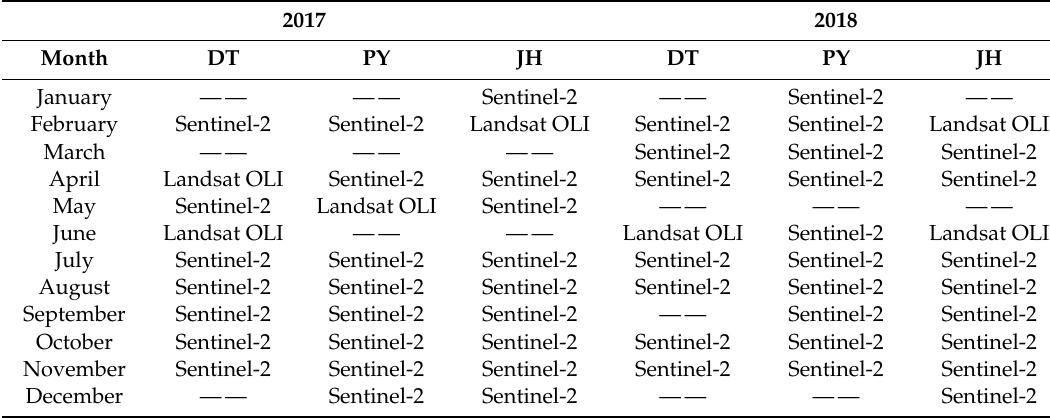
Table 1. Remote sensing data source for DT, PY, and JH in 2017 and